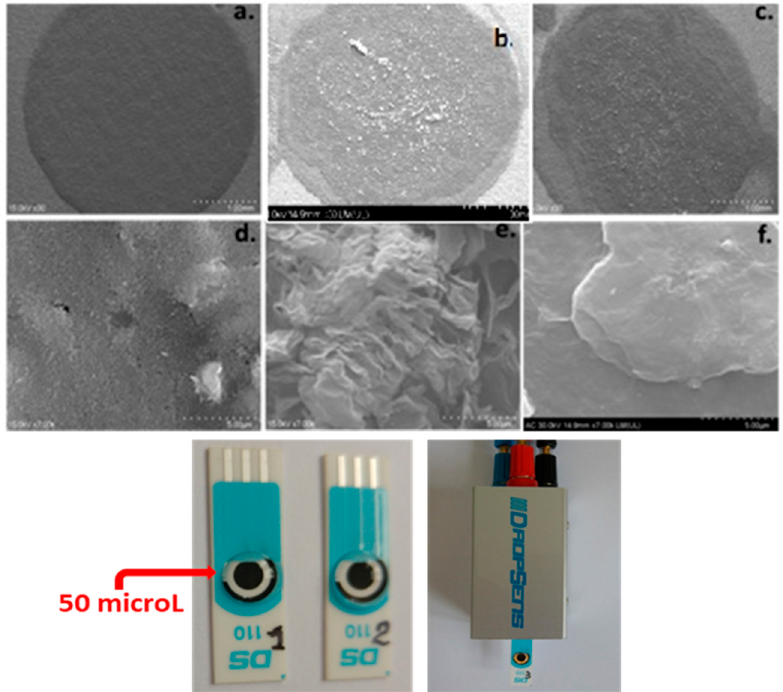
Figure 1. Low and high-magnification SEM images of the electrodes: bare DS electrode ( a , d ); DS/TRGO ( b , e ); DS/GO ( c , f ); scale bar 1.0 mm ( a – c ); scale bar 5.0 µm ( d – f ). Optical images of screen-printed electrodes: DS (1); DS/GO (2); DS/TRGO (3).